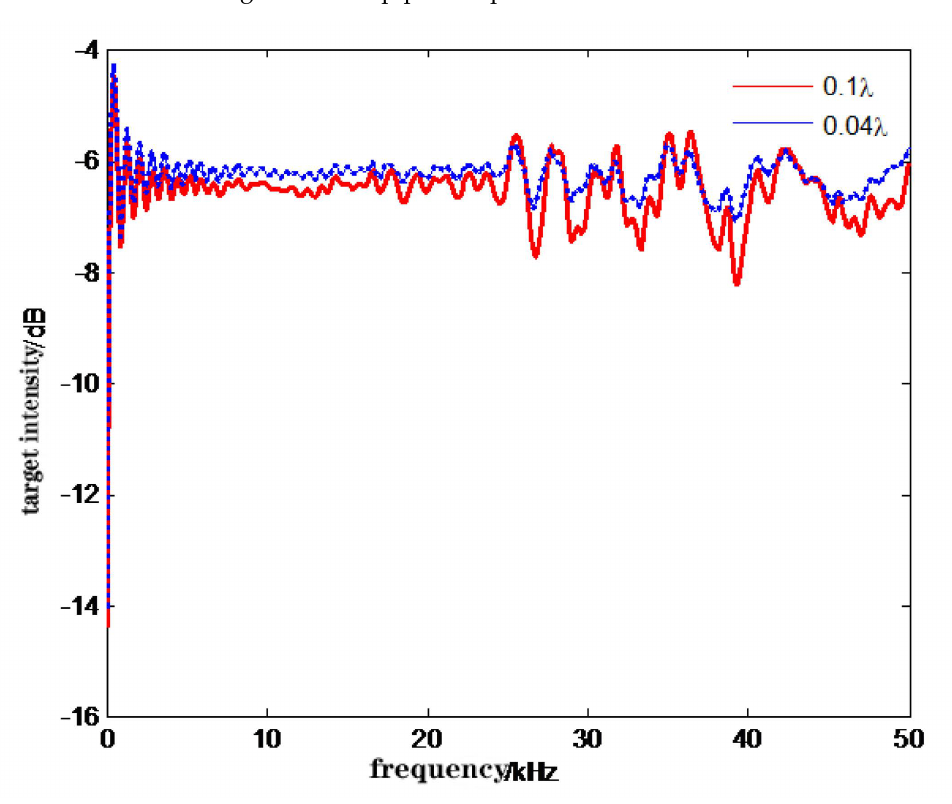
Figure 9. Sphere frequency–intensity